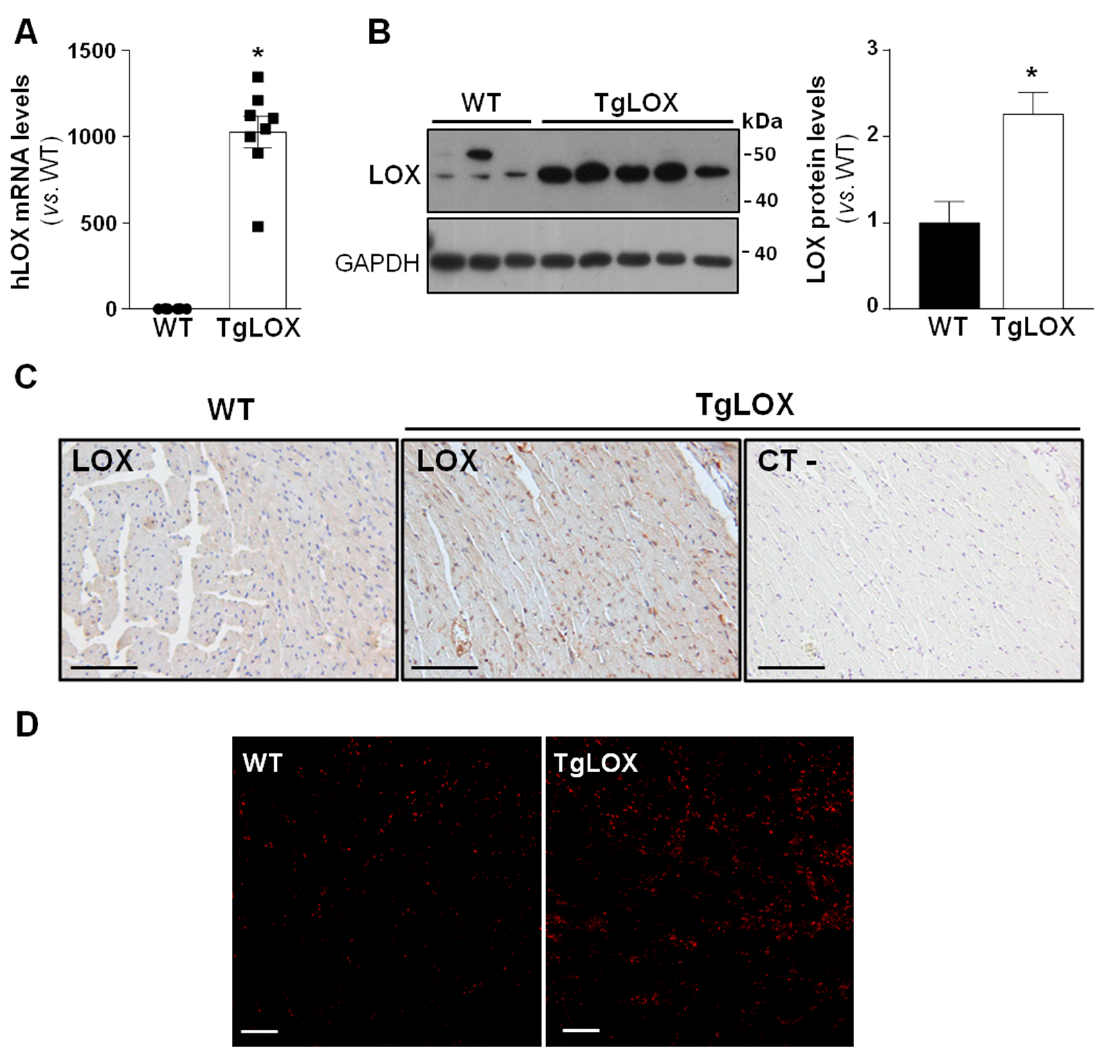
Figure 1. TgLOX mice show increased LOX expression in the myocardium and enhanced ROS production. ( A ) Human LOX (hLOX) mRNA levels were analyzed in hearts from wild-type (WT) and TgLOX mice by real-time PCR. Levels of human LOX mRNA were undetectable in WT mice, but an arbitrary value of 1 was attributed for comparative purposes only (WT, n = 6; TgLOX, n = 8). ( B ) Protein levels of LOX were assessed by Western blot in heart lysates from WT and TgLOX mice. GAPDH levels are shown as a loading control. Representative immunoblot images have been included. The histogram shows the result from the densitometric analysis (WT, n = 4; TgLOX, n = 6). Data are expressed as mean ± SEM. * p < 0.05 vs. WT. t -test ( A ) and Mann–Whitney test ( B ) were applied. ( C ) Immunohistochemical analysis of LOX in hematoxylin counterstained myocardial sections from these animals. A negative control, in which the primary antibody was excluded, was used to test for non-specific binding of the secondary antibody (bars: 100 µ m). ( D ) Representative dihydroethidium (DHE) staining in WT and TgLOX mice hearts (bars: 100 µ